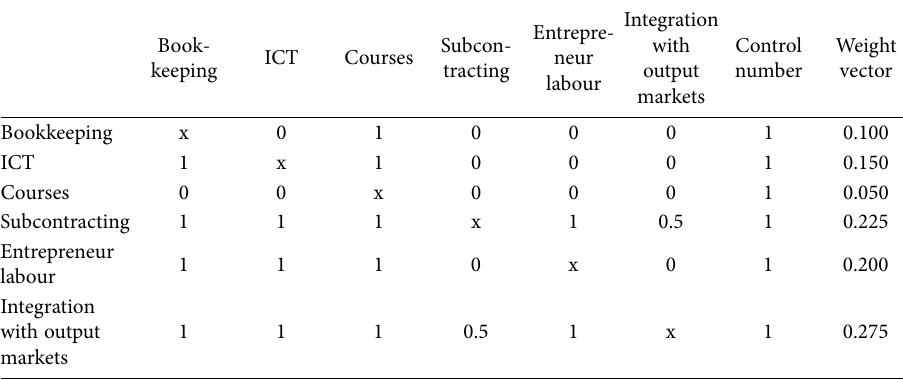
Table 4 . Weight matrix related to entrepreneurial dynamism.